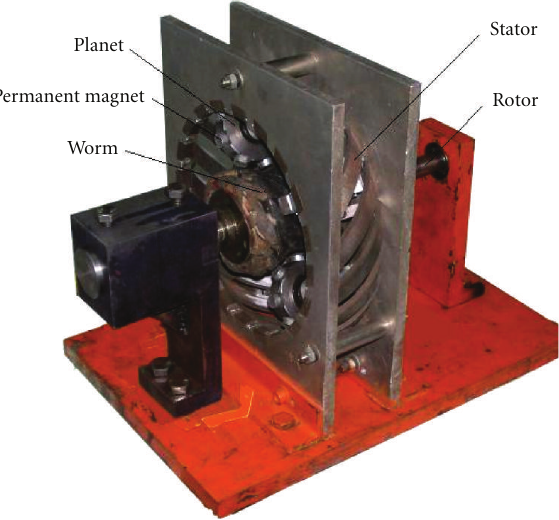
Figure 1: The electromechanical integrated toroidal